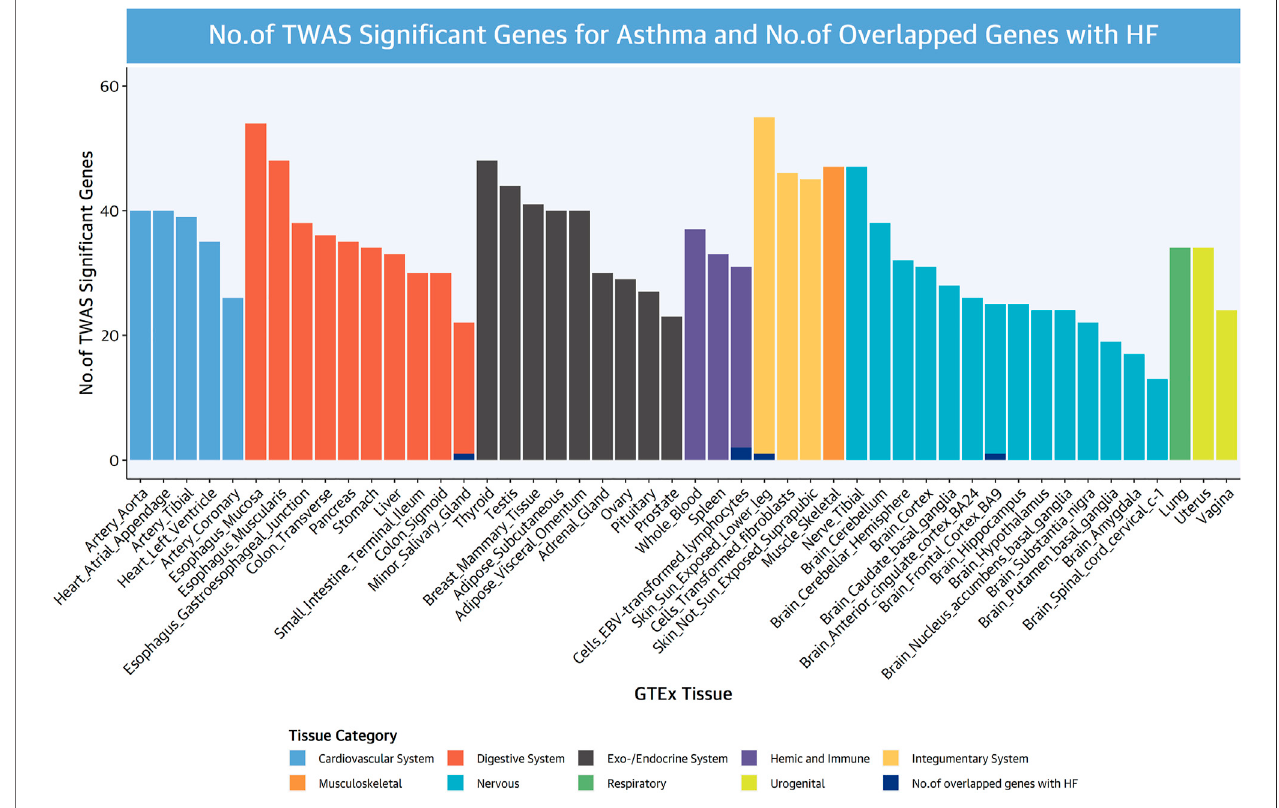
FIGURE 3 | Numbers of signi fi cant genes for asthma and numbers of overlapped genes with HF. Signi fi cant genes were identi fi ed by P Bonferroni < 0.05.